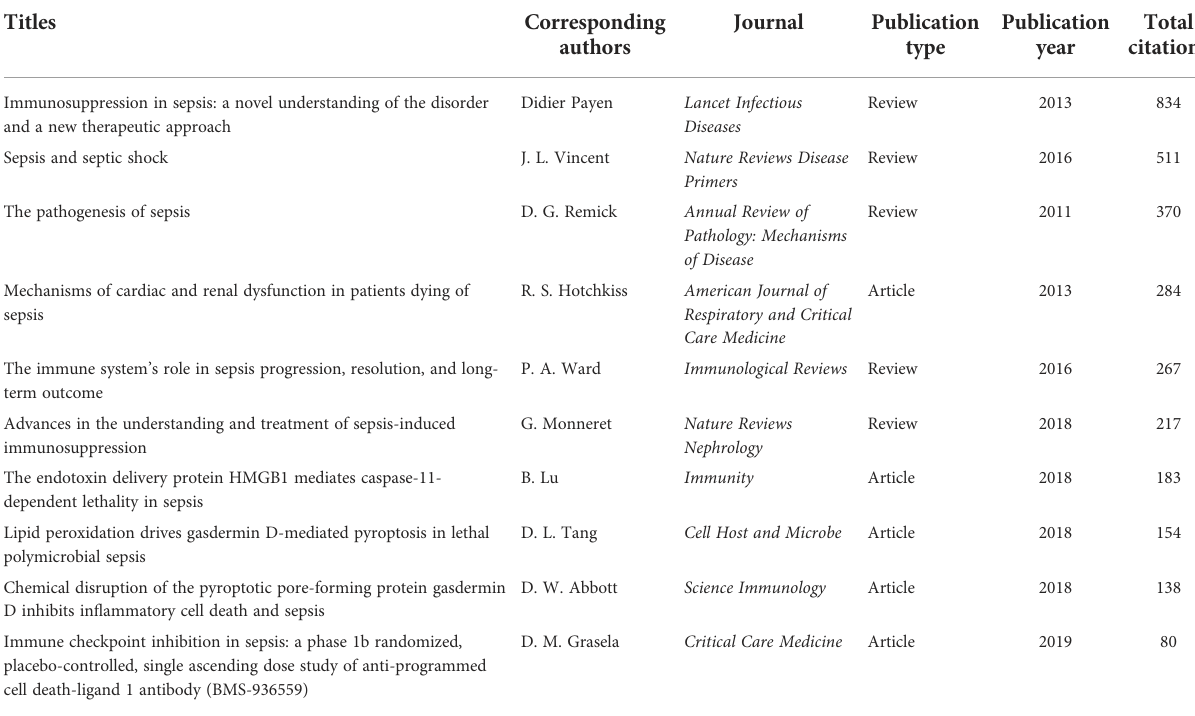
TABLE 2 Top 10 highly cited papers related to sepsis and immune response.